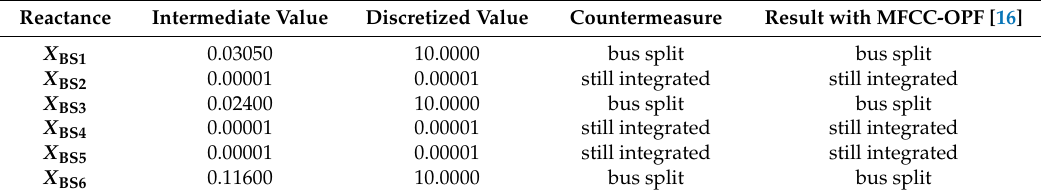
Table 8. MFCC-OPF adopted a soft-discretization technique within the solution procedure, and it is only applicable to the decision making on bus splitting and line opening The result of MFCC-OPF was the same as that of the proposed method. Table 8. X variables of each bus splitting candidate (Case 1). MFCC-OPF: modified fault current constrained optimal power flow.